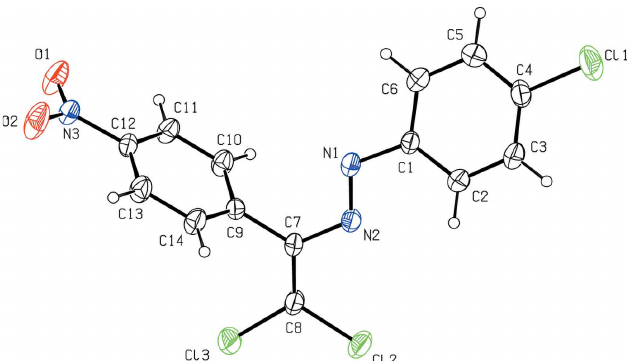
Figure 2 The molecular structure of (II) with displacement ellipsoids drawn at the 30% probability level.